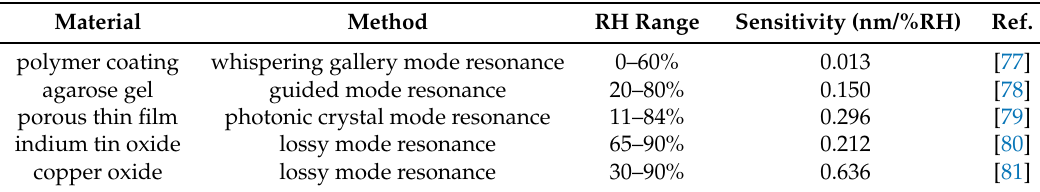
Table 2. Comparison of different optical RH sensors.